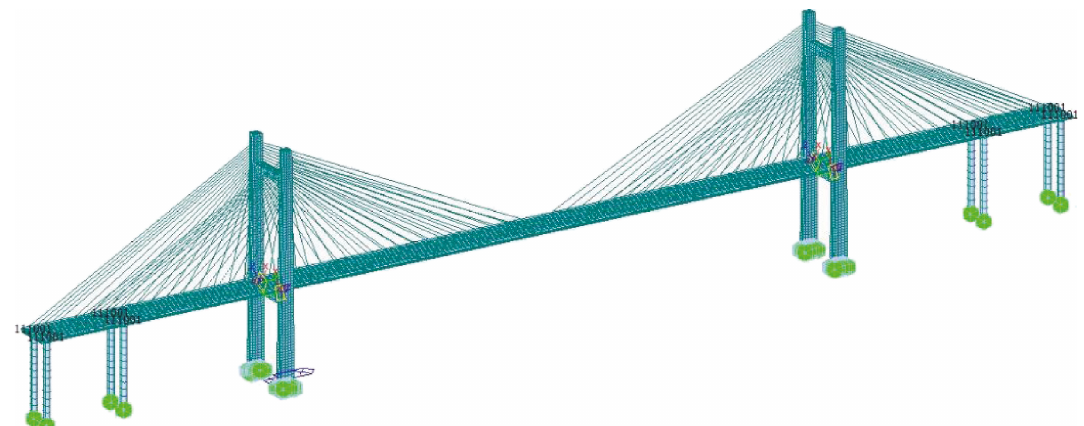
Figure 3: Boundary constraints of long-span